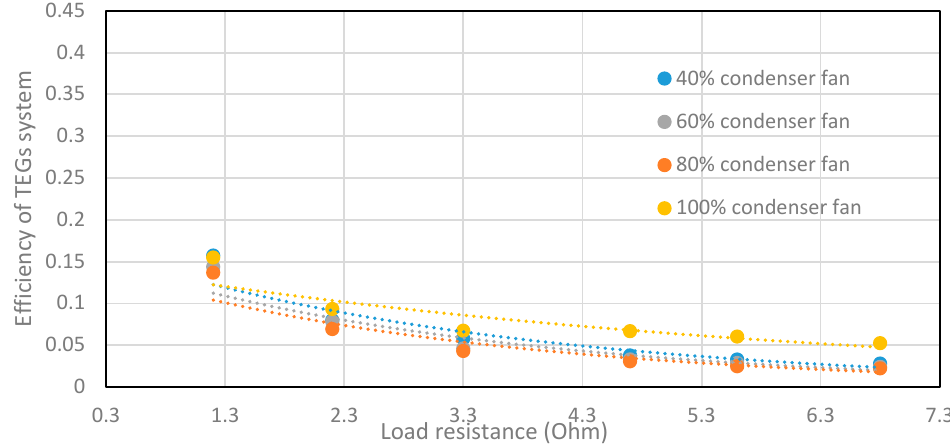
Figure 14. Variation of TEGs efficiency with load resistance at different values of condenser load.